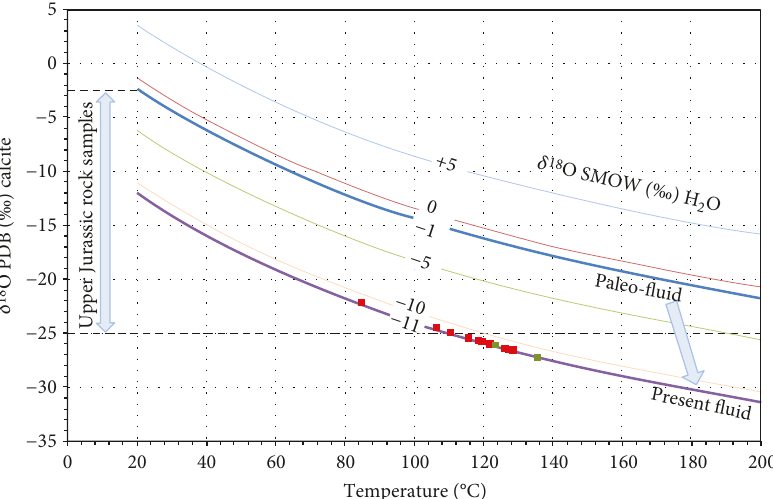
Figure 12: Isotope composition of water versus calcite crystals according to Friedman and O'Neil [64]; red squares — scaling from the Unterhaching geothermal plant, green squares — scaling from the Kirchstockach geothermal